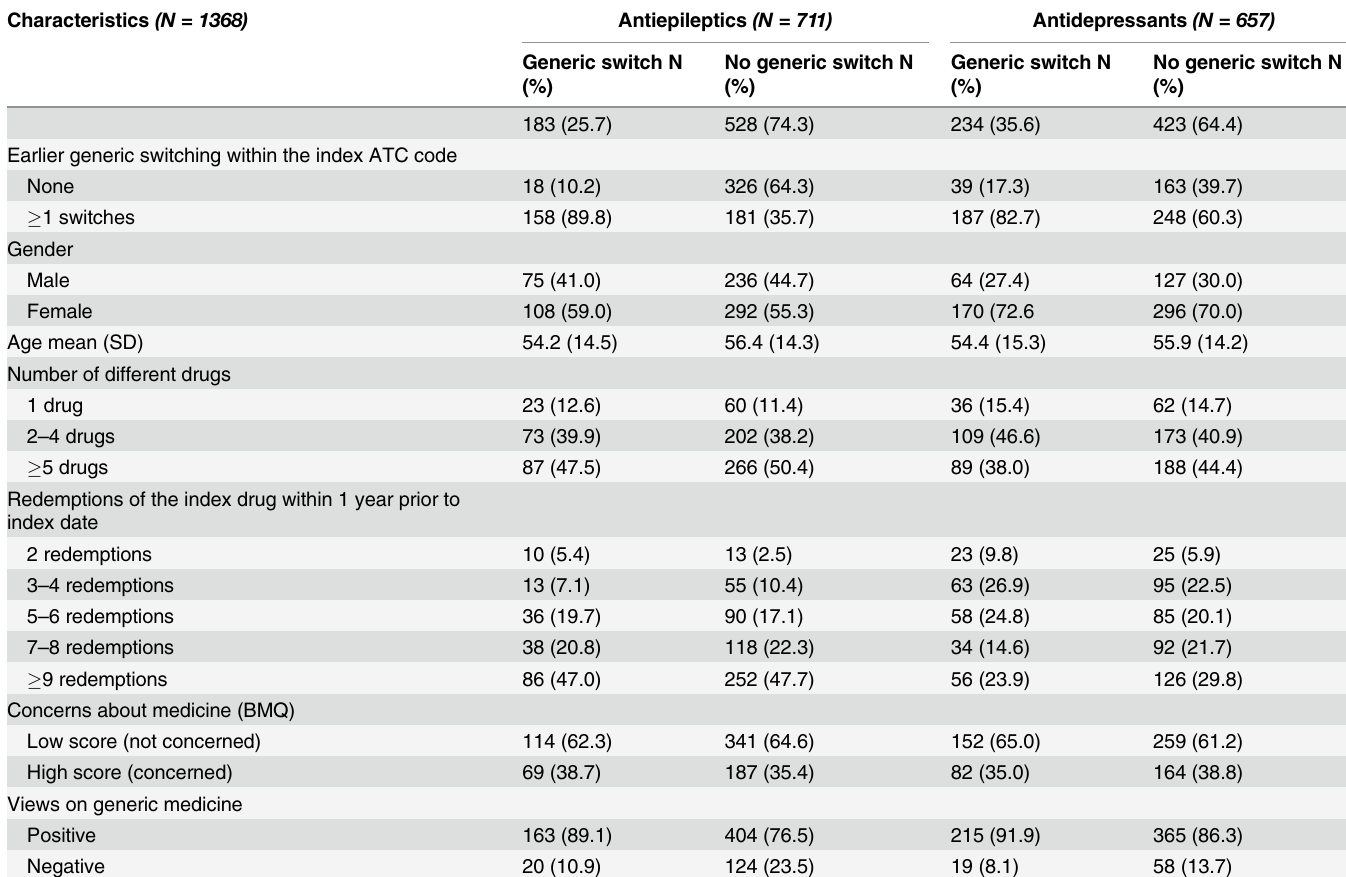
Table 1. Characteristics of the study population, strati fi ed on whether a generic switch took place on the index day. Characteristics (N =